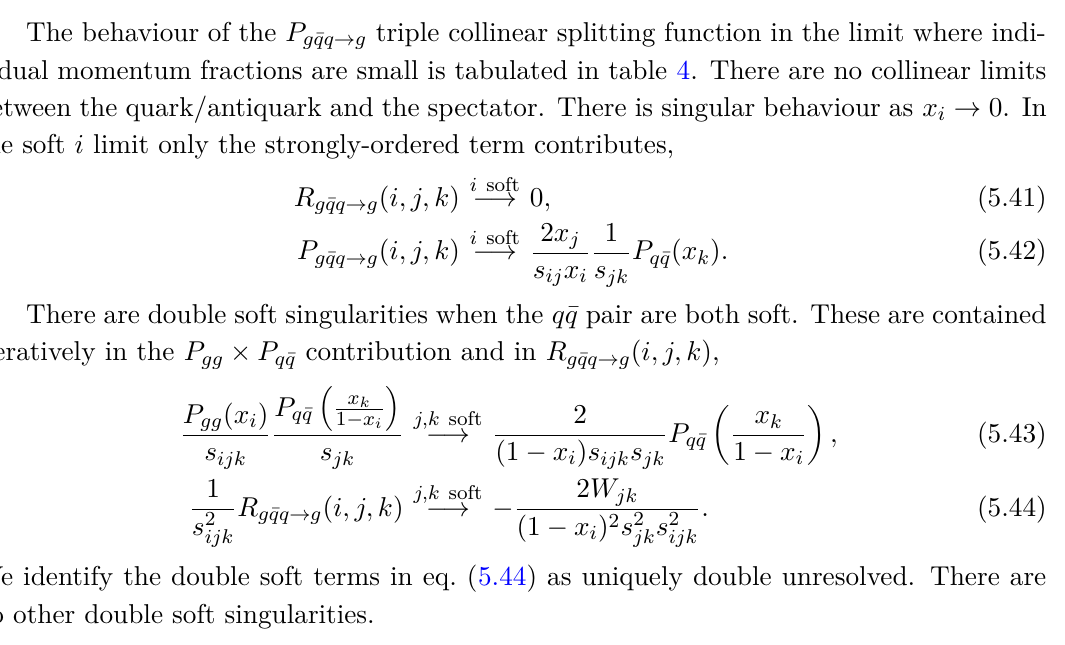
Table 4 . Singular Behaviour of the P g ¯ qq → g triple collinear splitting function in the limit where individual momentum fractions are